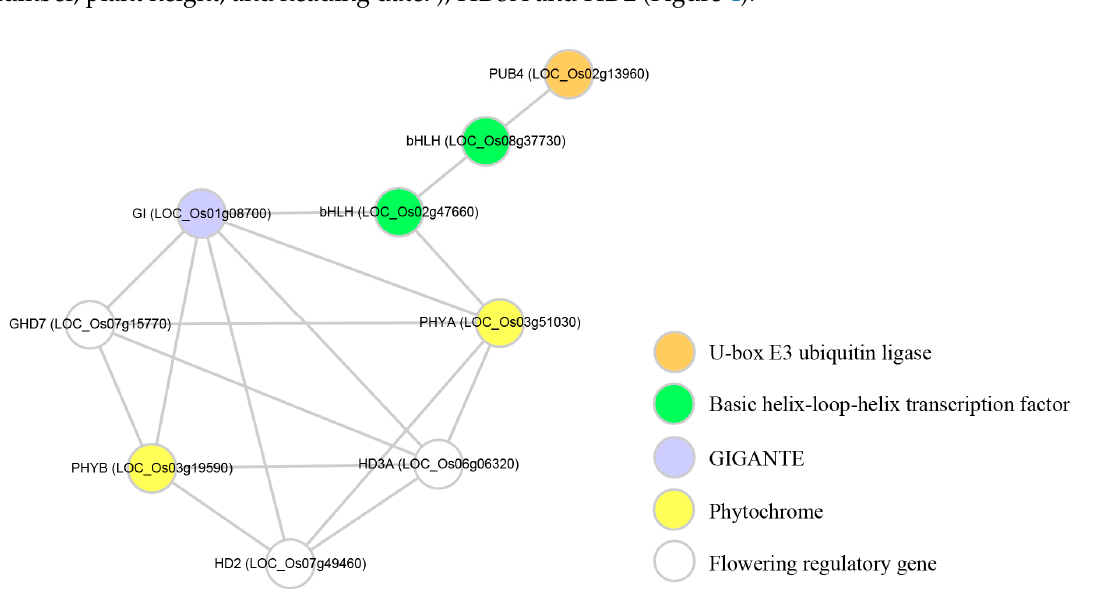
Figure 4. Construction of predicted protein-protein interaction networks associated with OsPUB4 and OsGI. Using the STRING tool, we found seven proteins that are expected to interact with OsPUB4 (orange circle) and OsGI (blue circle). Three of the seven proteins were identified as flowering regulatory genes (White circles), two as phytochrome (yellow circles), and two as bHLH TF (green circles).